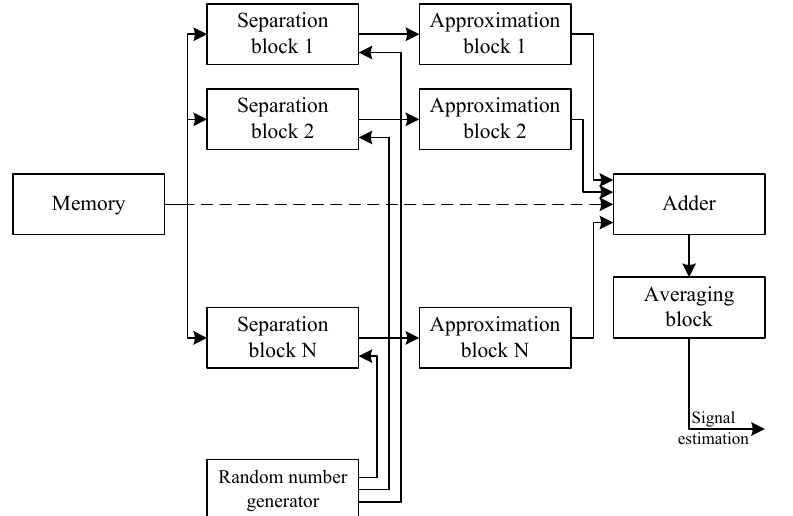
Fig. 2. Flowchart of an algorithm that implements the method of propagating estimates of the useful component.